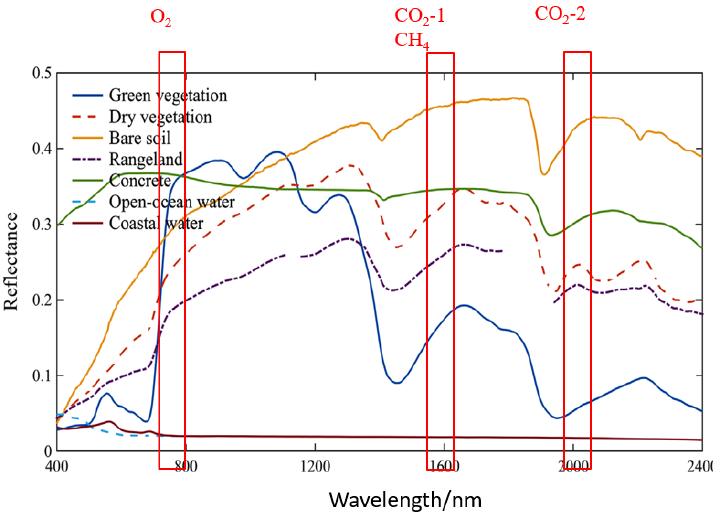
Figure 6. S urface reflectivity curve of different surface feature types in the GMI spectral channel.